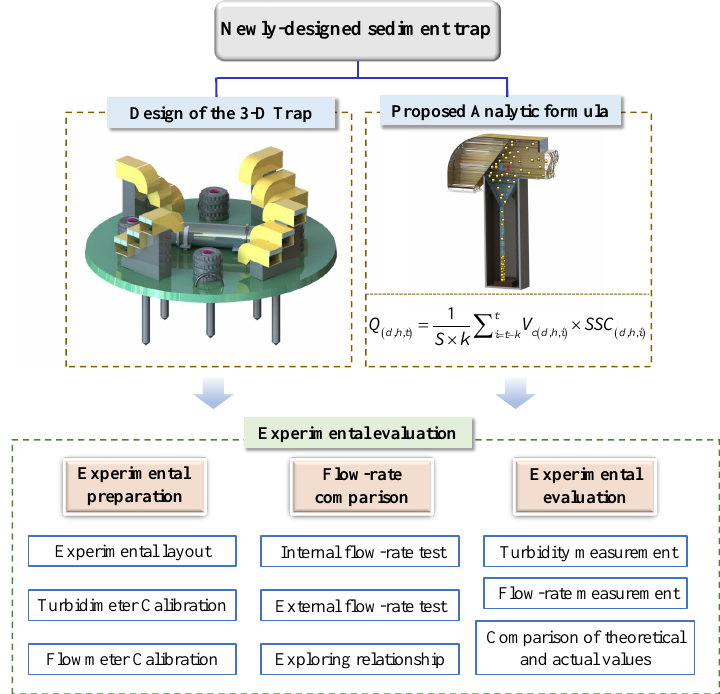
Figure 4. Flowchart of the methodology.